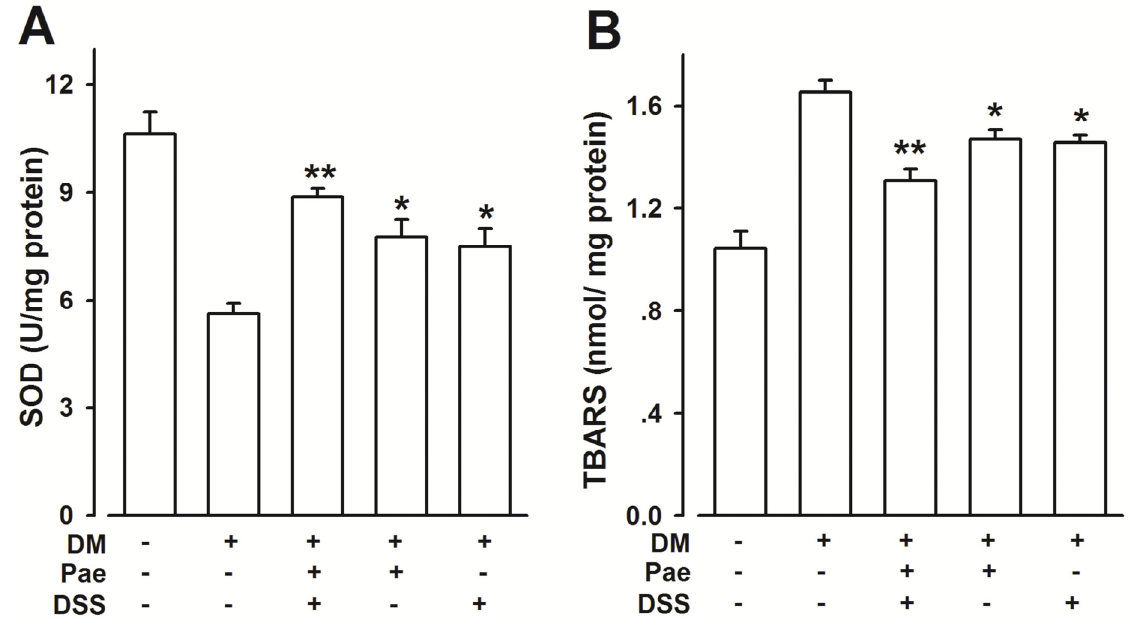
Figure 6. Effects of Pae + DSS on SOD activity and TBARS content from rings in all groups. The levels of SOD activity ( A ) and TBARS content (B) were assessed in the arterial tissues ( n = 8). ** p < 0.01 and * p < 0.05 compared with the corresponding DM group. Results are given as the mean ± SEM of three independent